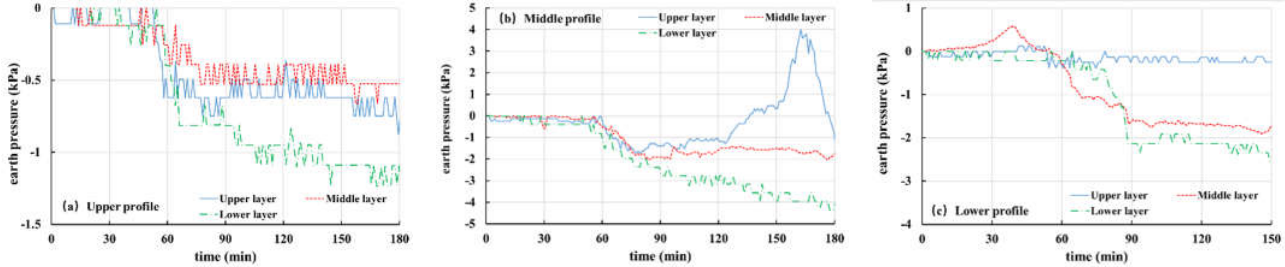
Figure 16. Curves of earth pressure in Test 1 (20 mm, 30 mm/h): ( a ) upper profile; ( b ) middle profile; ( c ) lower profile.